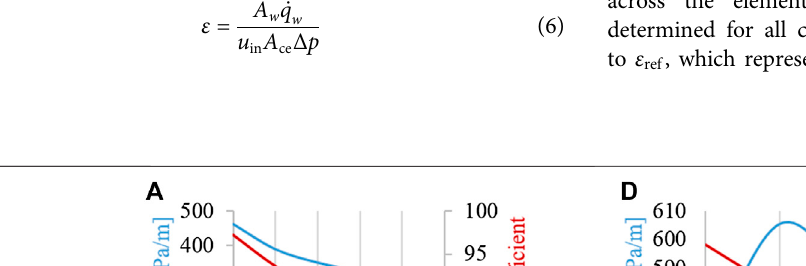
Frontiers in Energy Research |